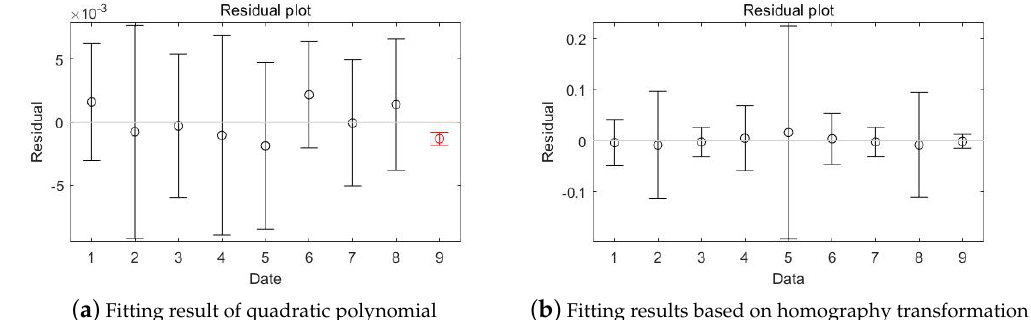
Figure 12. Schematic diagram of gaze point ordinate surface fitting.